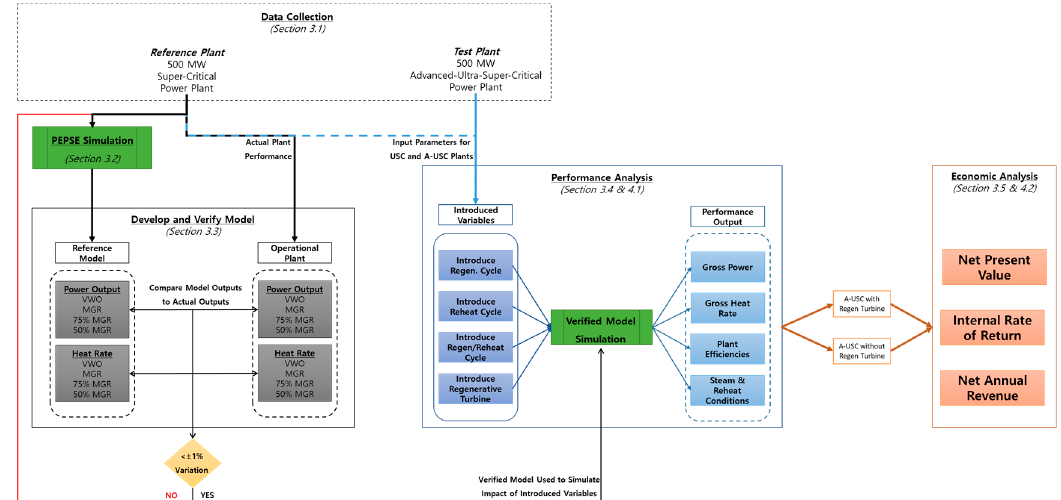
Figure 2. Data collection and research methodology flow diagram.